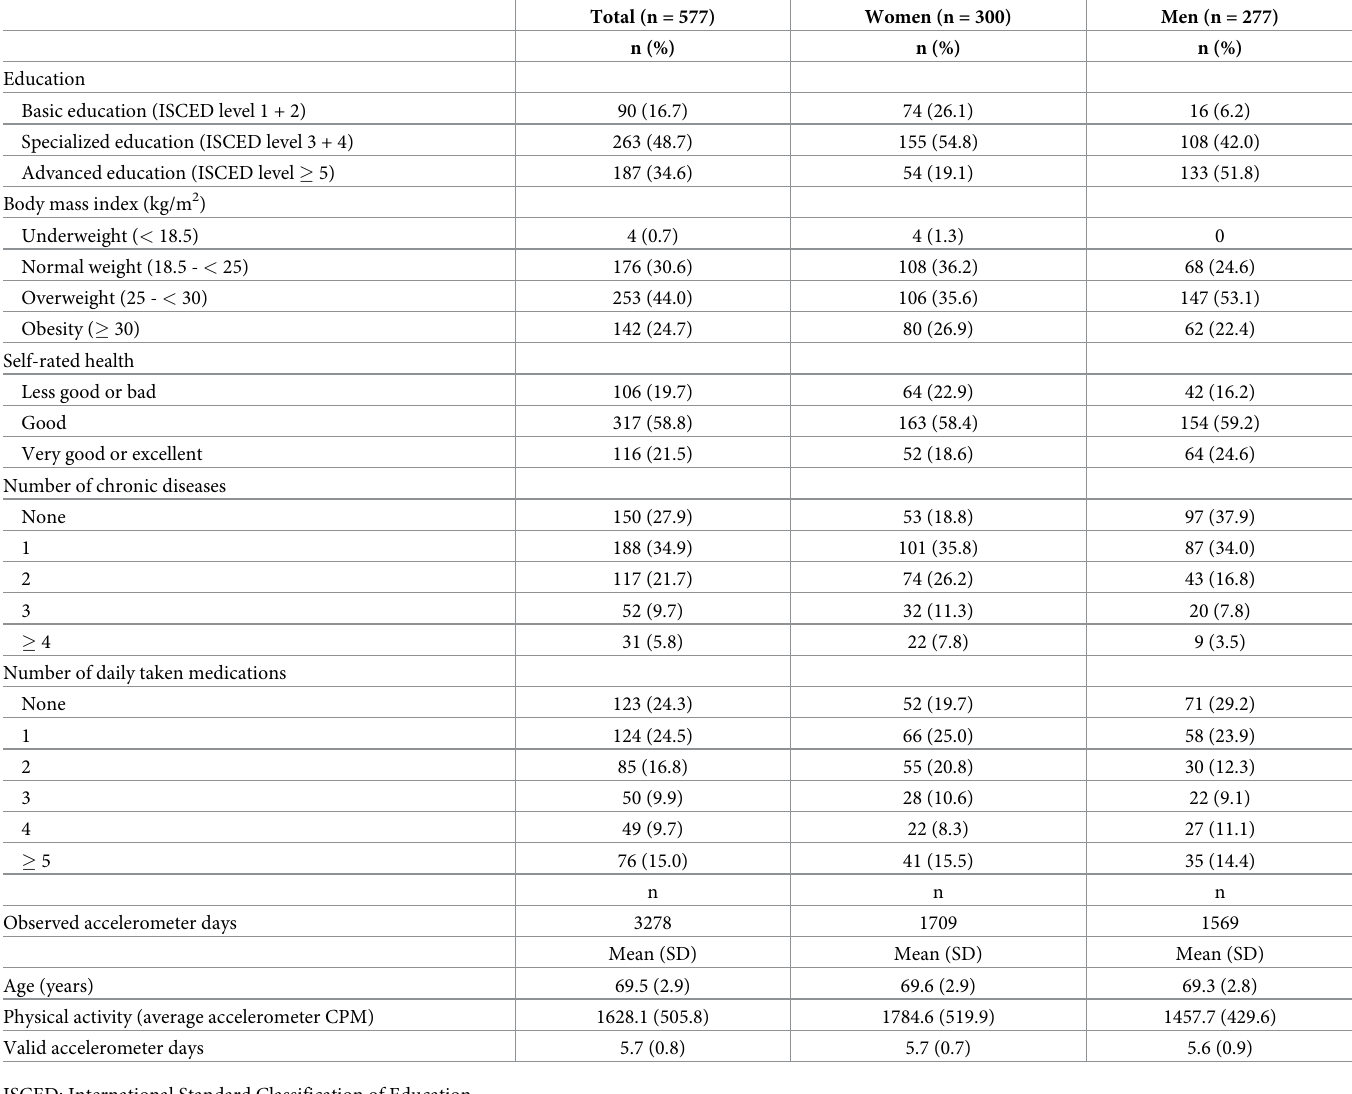
Table 2. Characteristics of the study